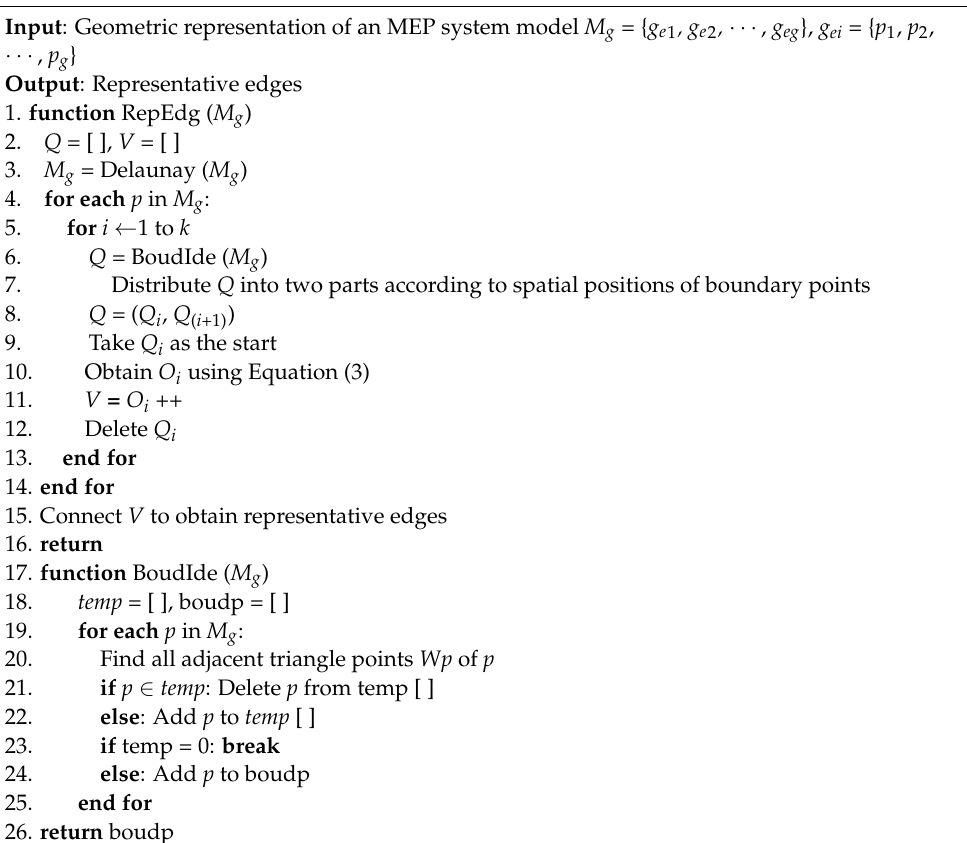
Algorithm 1: RepEdg —Representative edge extraction